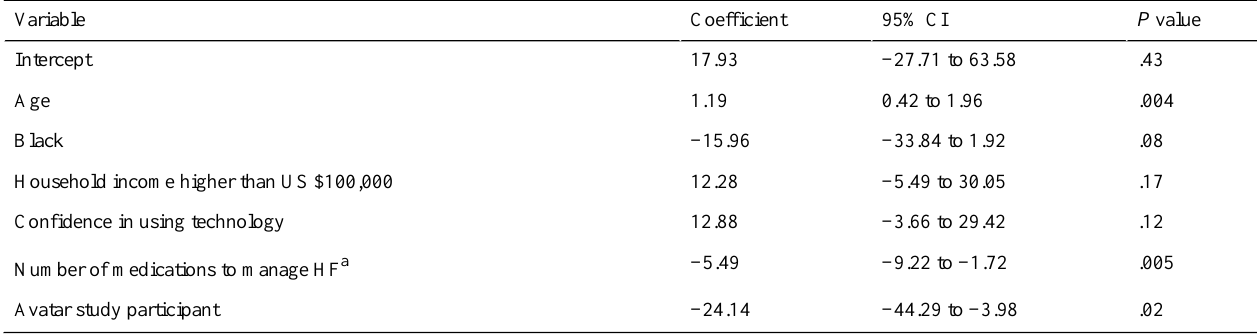
Table 2. Linear regression model for predicting the number of times that the patient used the voice interface